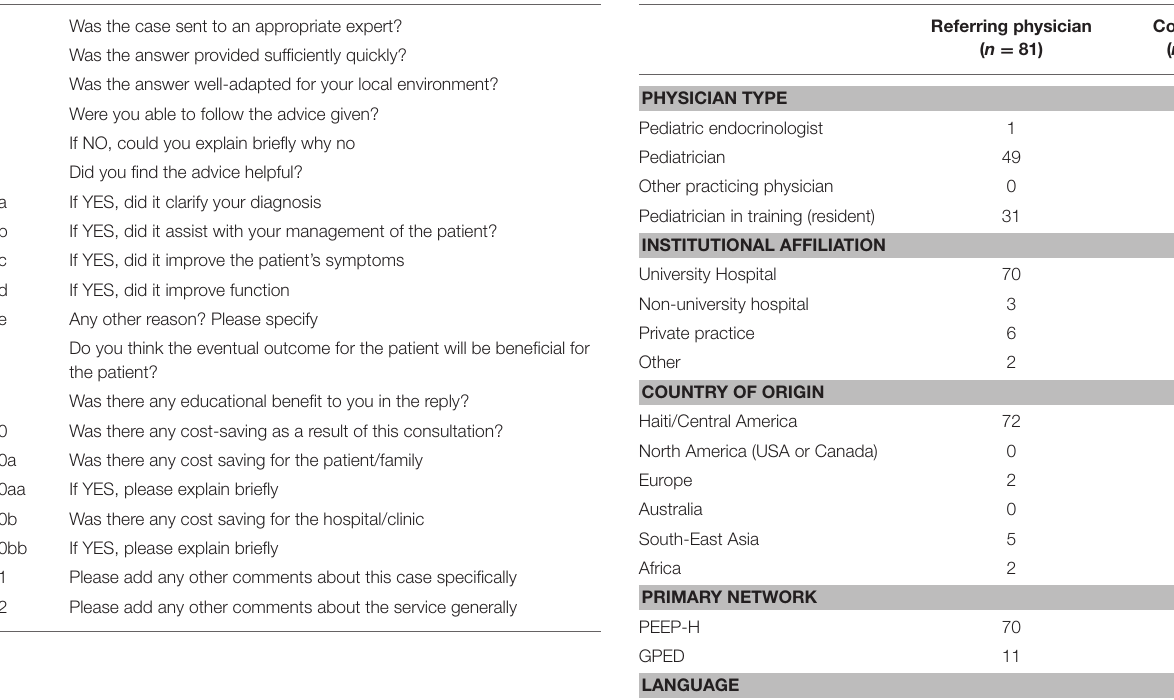
TABLE 2 | CollegiumTelemedicus automatic evaluation questionnaire. TABLE 3 | Participant